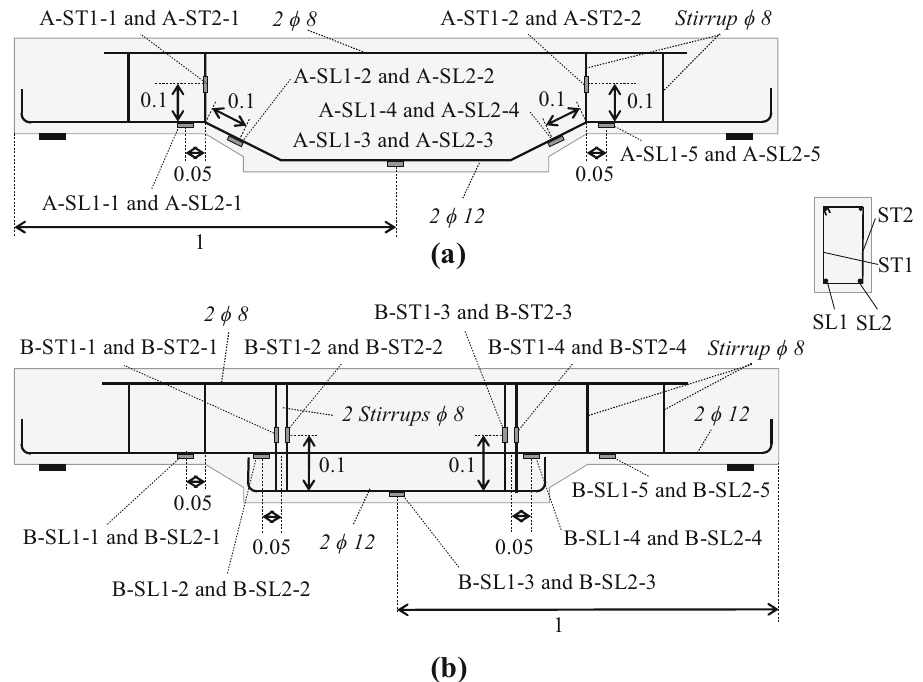
Fig. 5 Reinforcement layout and location of strain gauges. a Type A specimens. b Type B specimens.